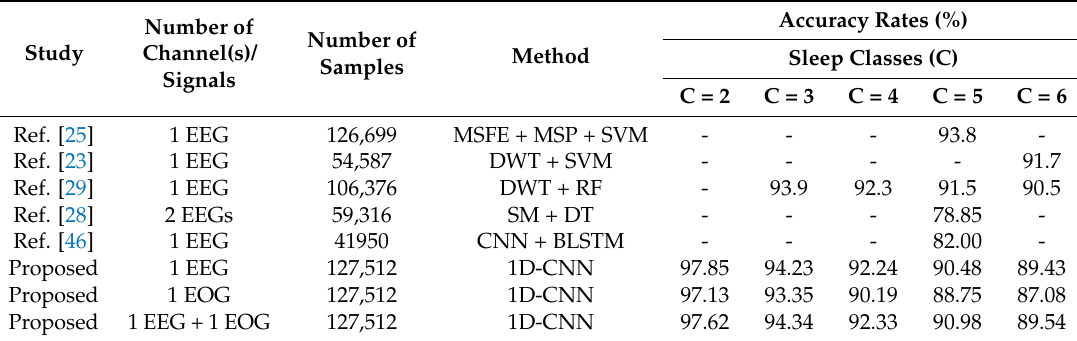
Table 12. Summary of automated sleep stage classification using the sleep-edfx dataset. CNN: